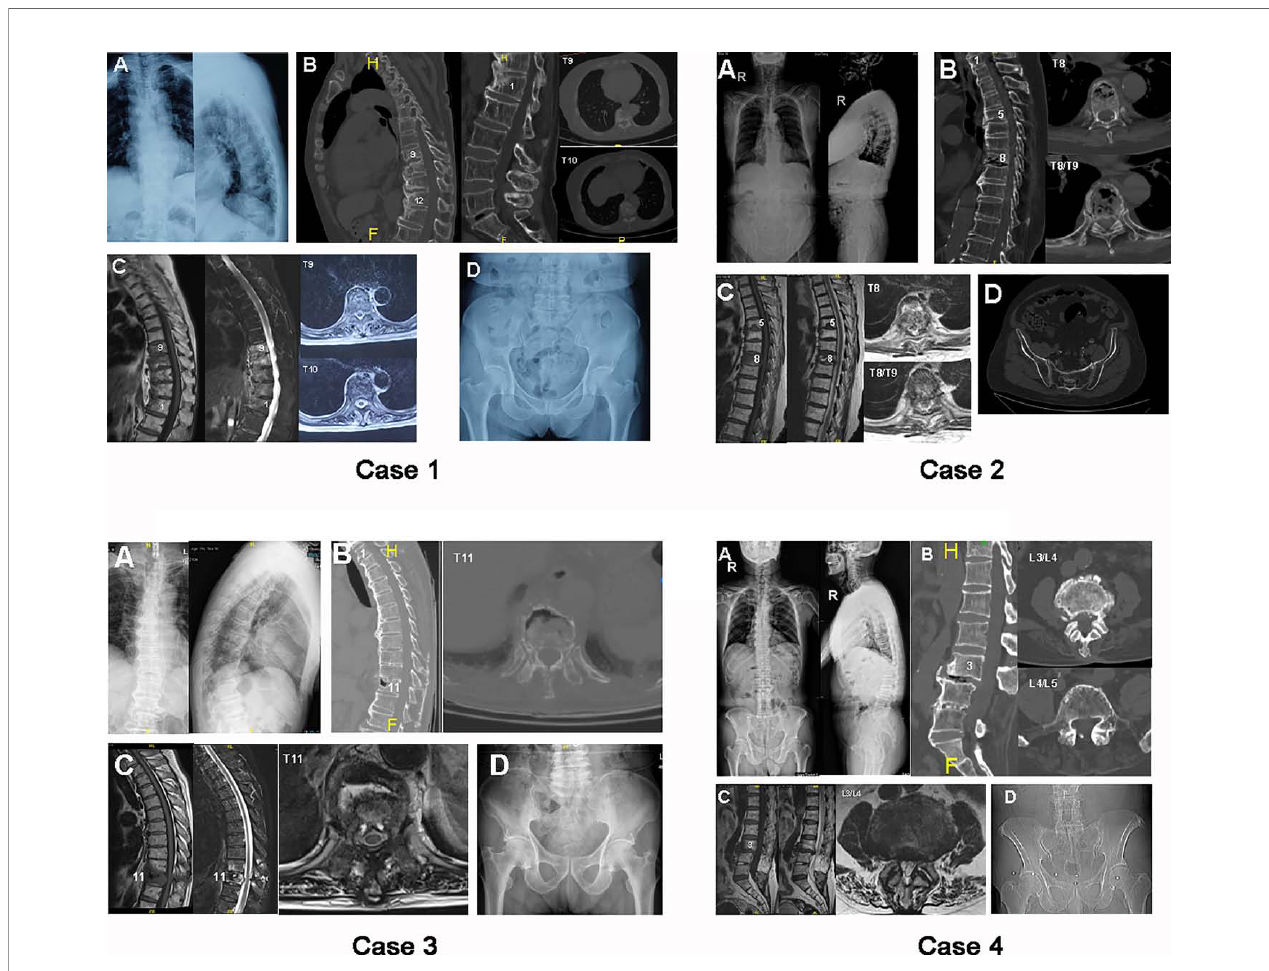
FIGURE 1 | Case 1 : preoperative radiograph of case 1, a 72-year-old female. (A) Plain X-ray standing anteroposterior (AP) and lateral images. (B) Sagittal and axial computed tomography (CT) images of thoracic and lumbar segments. (C) Sagittal T1-weighted ( left ), T2-weighted ( middle ), and axial magnetic resonance (MR) scans of thoracic vertebrae. (D) Pelvic radiograph used to exclude ankylosing spondylitis (AS). Case 2 : preoperative radiograph of case 2, an 83-year-old male. (A) Plain X- ray standing AP and lateral images. (B) Sagittal and axial CT images of thoracic segments. (C) Sagittal T1-weighted ( left ), T2-weighted ( middle ), and axial MR scans of thoracic vertebrae. (D) Pelvic radiograph. Case 3 : preoperative radiograph of case 3, a 76-year-old male. (A) Plain X-ray standing AP and lateral images. (B) Sagittal and axial CT images of thoracic segments. (C) Sagittal T1-weighted ( left ), T2-weighted ( middle ), and axial MR scans of thoracic vertebrae. (D) Pelvic radiograph. Case 4 : preoperative radiograph of case 4, a 73-year-old male. (A) Plain X-ray standing AP and lateral images. (B) Sagittal and axial CT images of lumbar segments. (C) Sagittal T1-weighted ( left ), T2-weighted ( middle ), and axial MR scans of lumbar vertebrae. (D) Pelvic